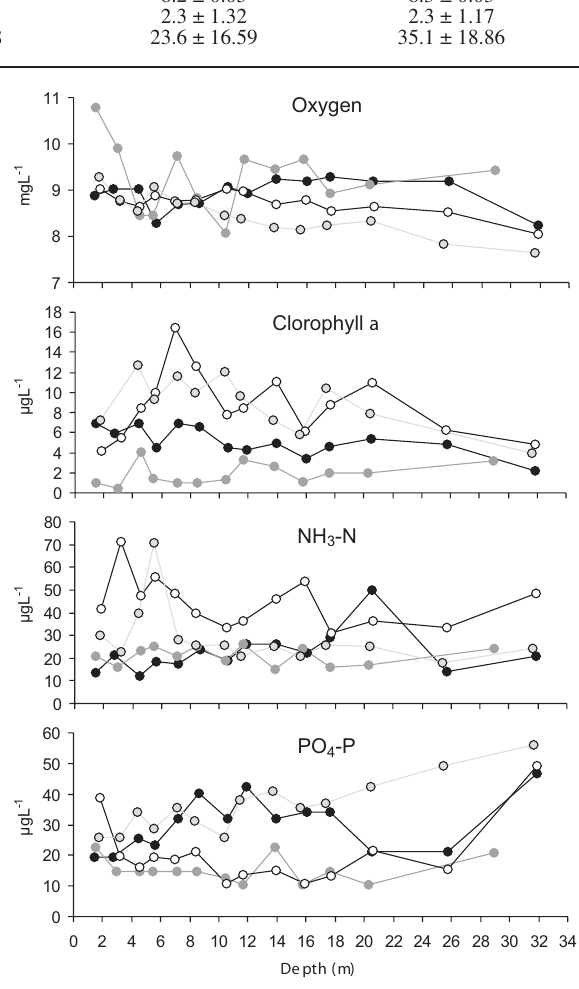
Fig. 1 . – Variation of oxygen, chlorophyll a , ammonia (nh phosphates (Po -P) along the depth gradient, for the main seasons: 4 spring/summer 01 and 02, winter 02 and autumn